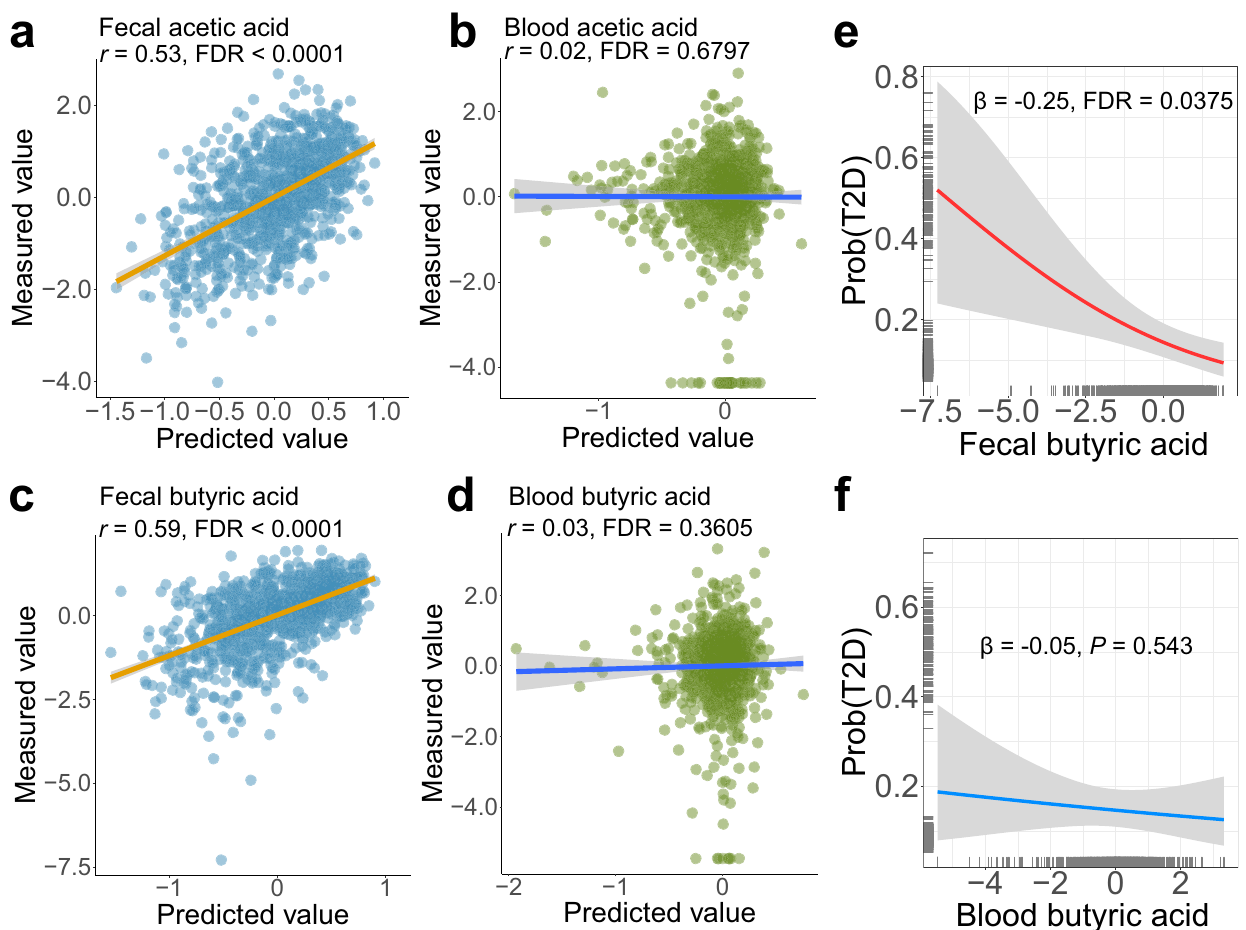
Fig. 5 | Comparisons between paired fecal and blood SCFAs in associating taxonomic composition and type 2 diabetes. a The association between taxo- nomic composition and fecal acetic acid. b The association between taxonomic composition and blood acetic acid. c The association between taxonomic com- positionand fecalbutyricacid. d The association betweentaxonomic composition and blood butyric acid. The random forest model with fi ve-fold cross-validation is used to predict the fecal or blood metabolite levels based on taxonomic compo- sition.Thescatterplotisplottedbythepredictedandmeasuredmetabolitevalues. Spearman ’ scorrelationbetweenmeasuredandpredictedmetabolitevaluesisused to measure the association of taxonomic composition with fecal or blood